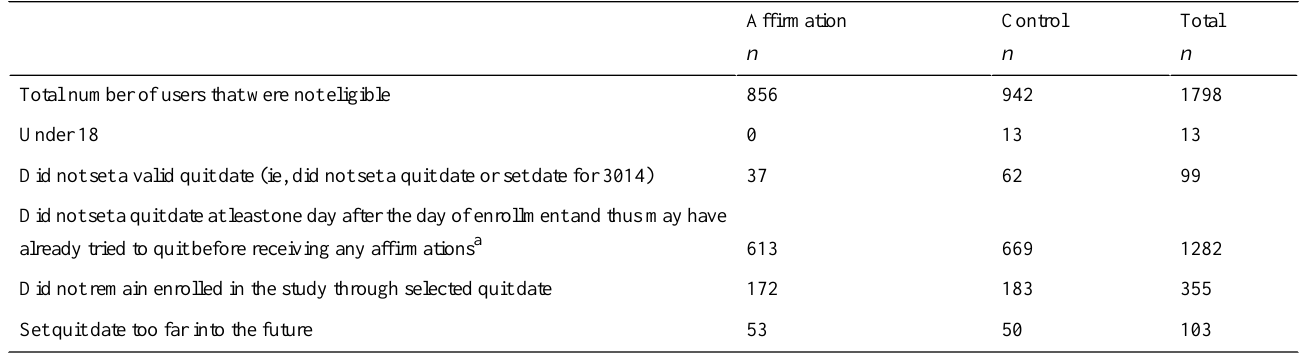
Table 3. Reasons for ineligibility for analyses as a function of study